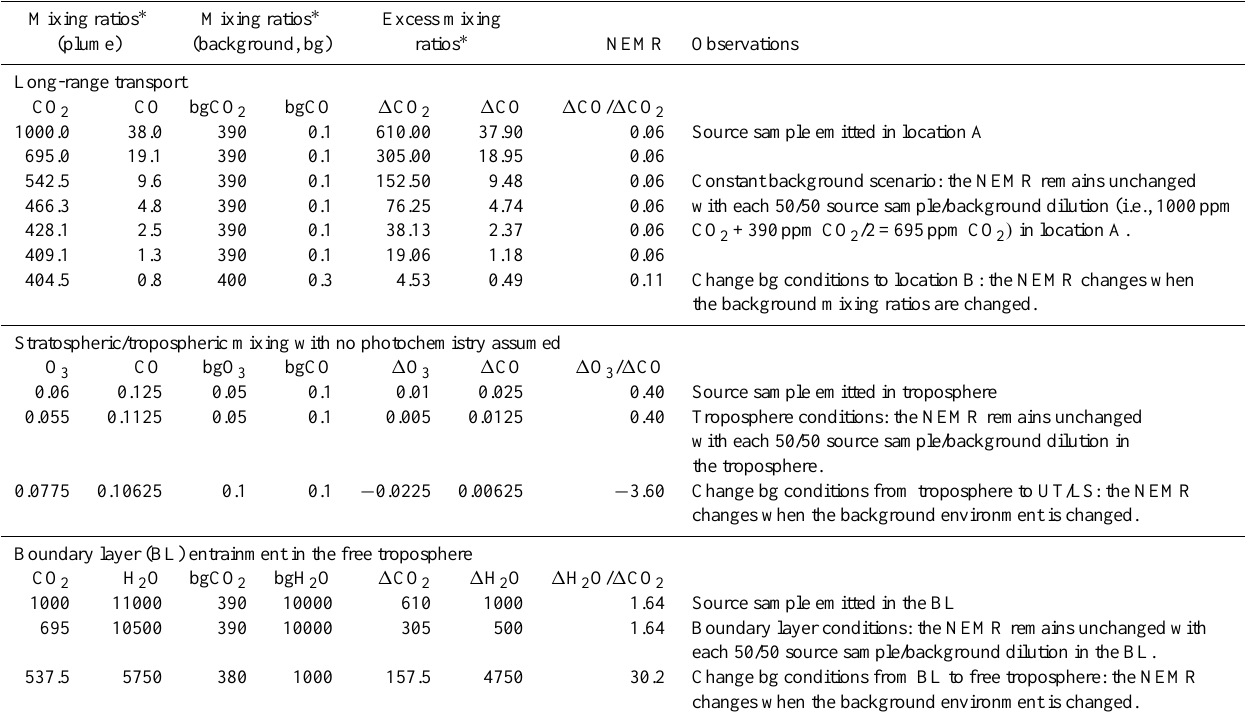
Table 1. The effect of various dilution scenarios on the calculation of the normalized excess mixing ratio (NEMR). Mixing ratios ∗ Mixing ratios ∗ Excess mixing (plume) (background, bg) ratios ∗ NEMR